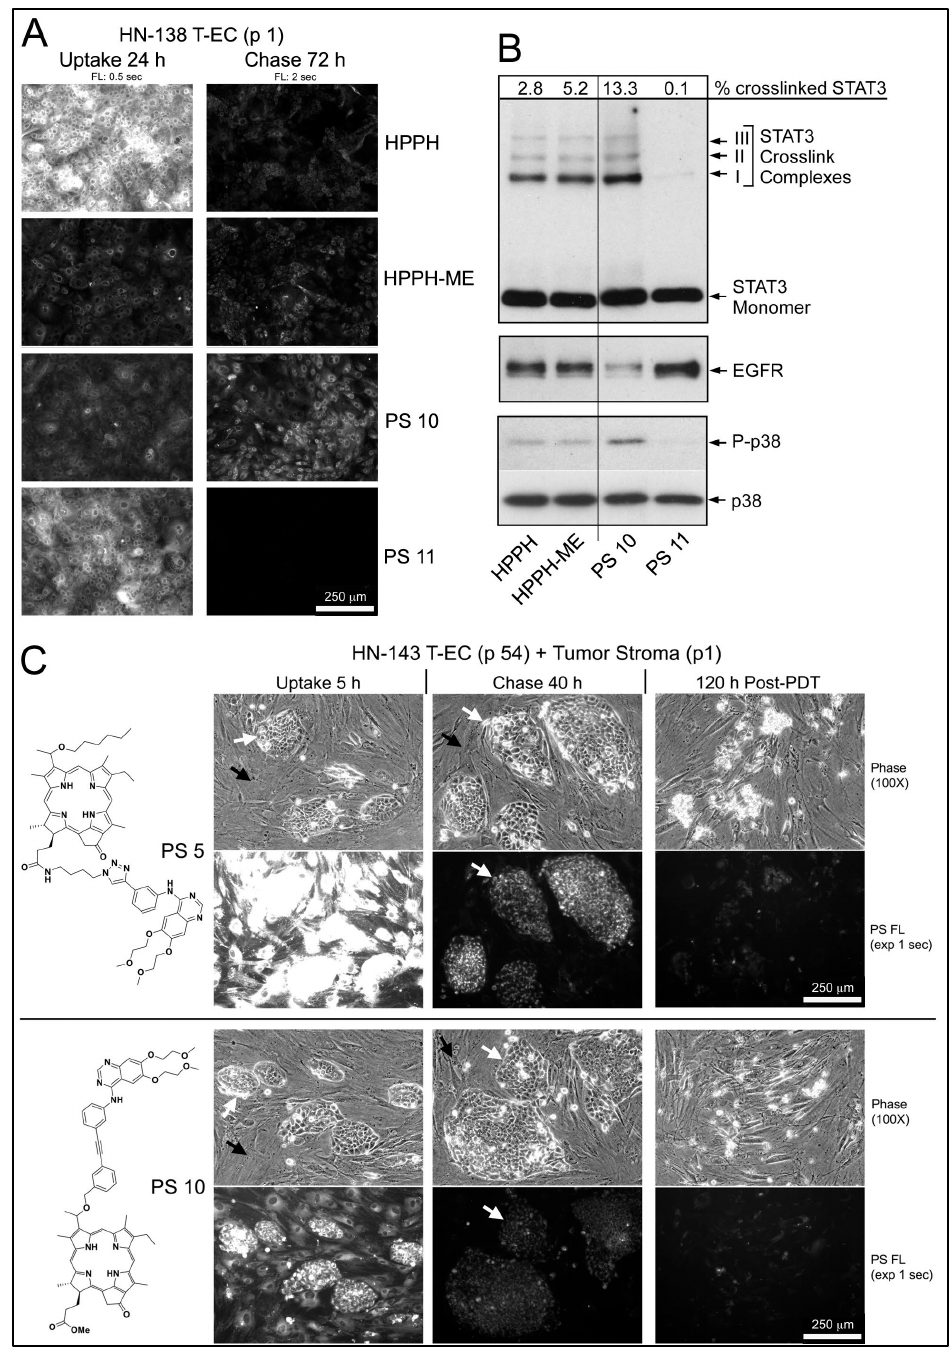
Figure 5. Photoreaction and PDT response by HN T-EC. ( A ), Cultures of HN-138 T-EC (p 1) were incubated for 24 h in media containing 10% FBS and 1.6 µ M of the indicated PSs. The cells were then cultured for 72 h in PS-free media. ( A ), Cell-associated fluorescence was imaged by microcopy. ( B ), Light-mediated photoreaction of the cells in ( A ) (9 min, 5.5 mW/cm 2 , 3 J/cm 2 ) resulted in products of photoreactions that are tightly correlated with PS level. ( C ), Co-culture of HN-143 T-EC (p 54) and T-Fb (p 1) were treated for 5 h with RPMI containing 10% FBS and 1.6 µ M PS 5 or PS 10, followed by 40 h chase. The cultures were exposed to 665 nm light (3 J/cm 2 ) and maintained in growth medium for additional 120 h. Culture morphology and level of PS fluorescence were imaged by microscopy using identical settings. Stromal cells survived but all tumor cells were killed, some of which are still attached as dead cell aggregate to the support matrix. The morphologically identifiable tumor cell clusters are indicated by white arrows and interspersed stromal cell layer by black